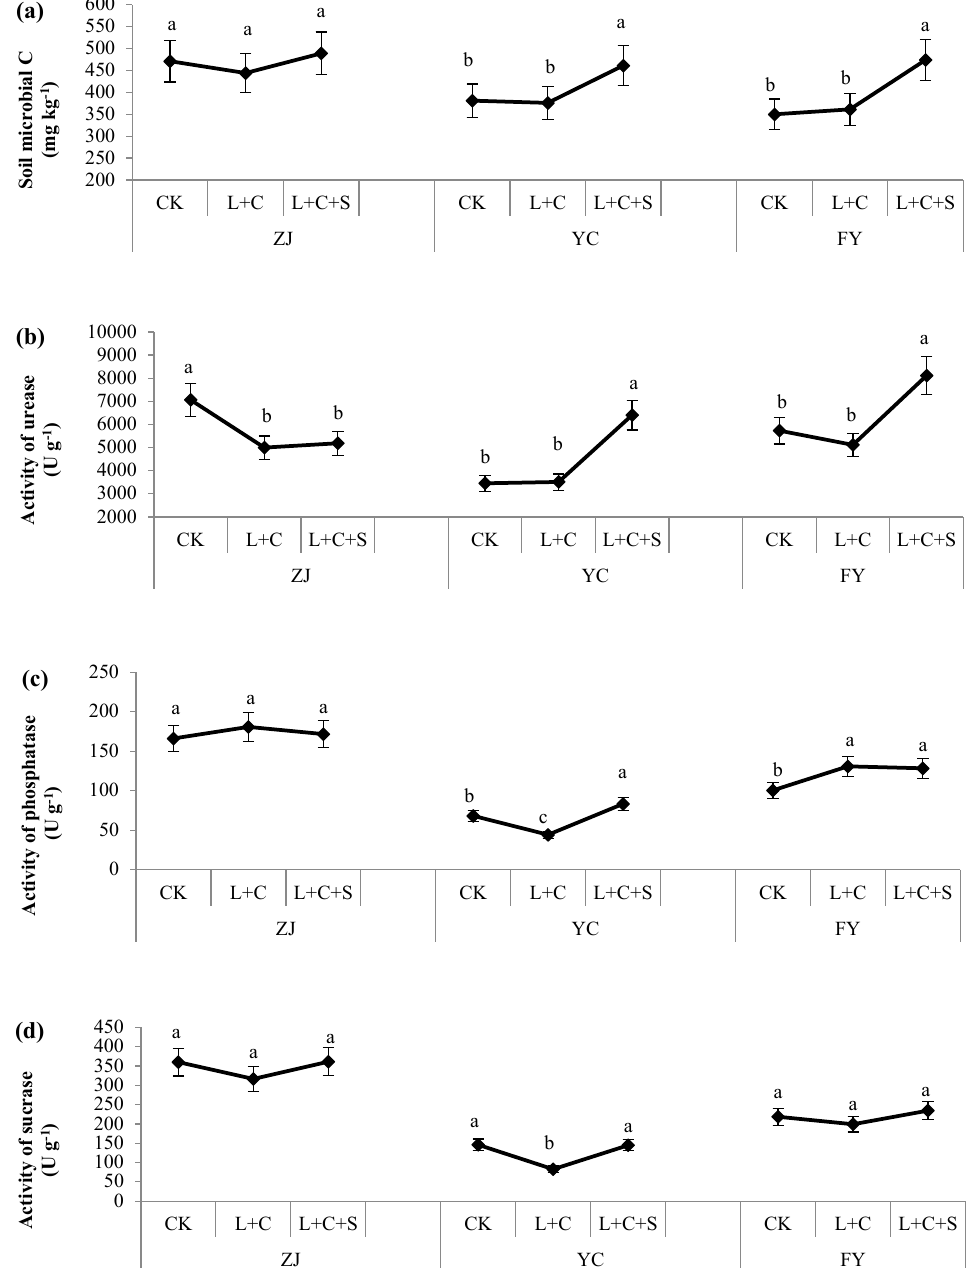
Figure 4. Soil microbial carbon ( a ) and activities of urease ( b ), phosphatase ( c ), and sucrose ( d ) in paddy soil treated by control with no passivators (CK), 9000 kg ha − 1 of lime + biochar with a rate of 1:1 (L + C), and 9000 kg ha − 1 lime + biochar + sepiolite with a rate of 1:1 (L + C + S). Values (means ± SD, n = 3) with different letters indicate significant differences between objects in the respective sites (separately for ZJ (Zhuji), YC (Yuecheng), or FY